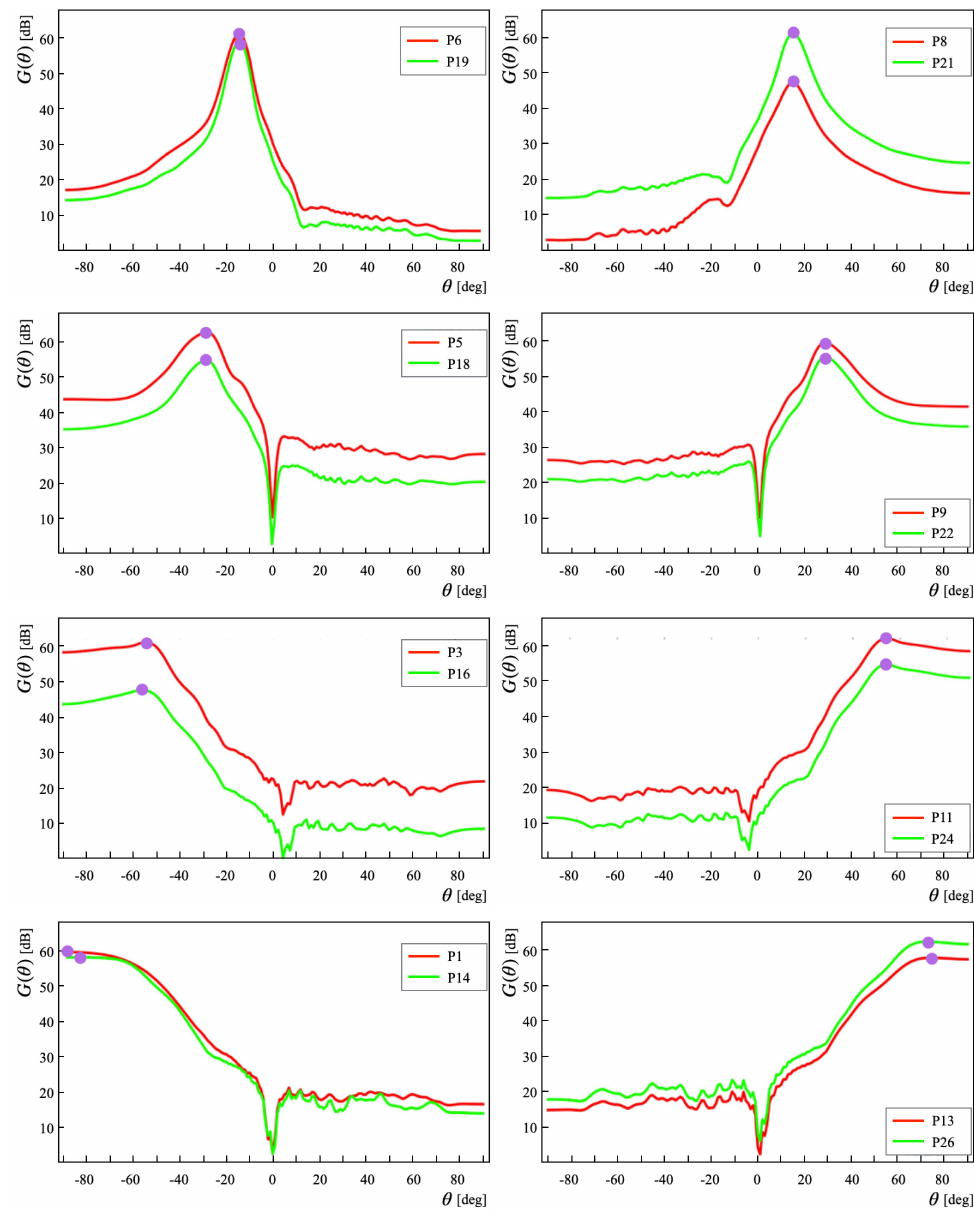
Figure 8. Angle estimation results at 16 positions ( θ g = ± 15 ◦ , ± 30 ◦ , ± 60 ◦ , and ± 90 ◦ ). Table 6 presents θ m at the respective positions. The error E between θ g and θ m is calculated